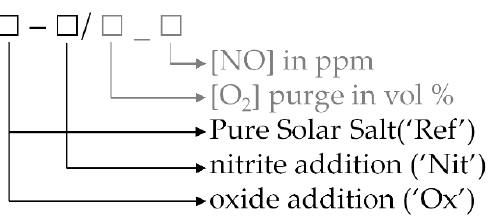
Figure 1. Experiment labeling according to salt composition and purge gas used. Table 1. List of experiments of this work (and literature). Labels are specified with regard to salt composition and purge gas composition. All salts exhibit Na/K ratios equal to that of ideal Solar Salt mixture (Na 65.5 mol %:K 35.5 mol %). Label